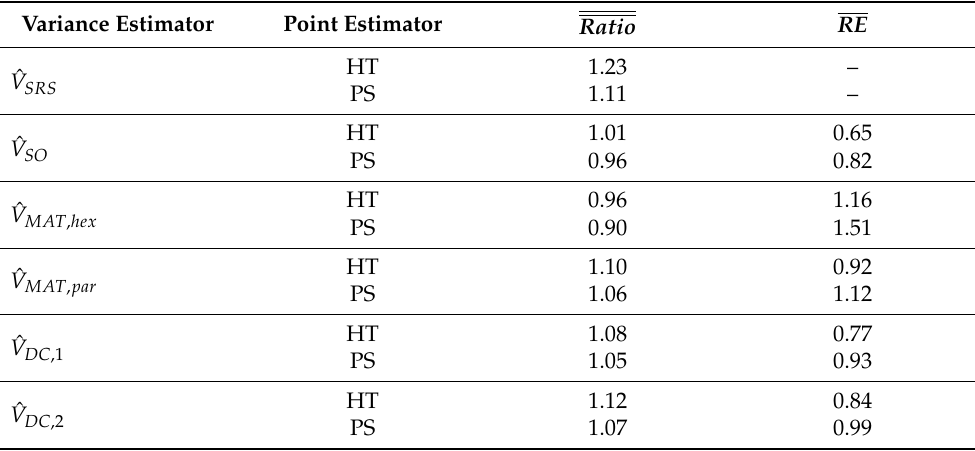
Table 3. Performance summaries of all variance estimators for the large spatial domain under HT and PS estimation.